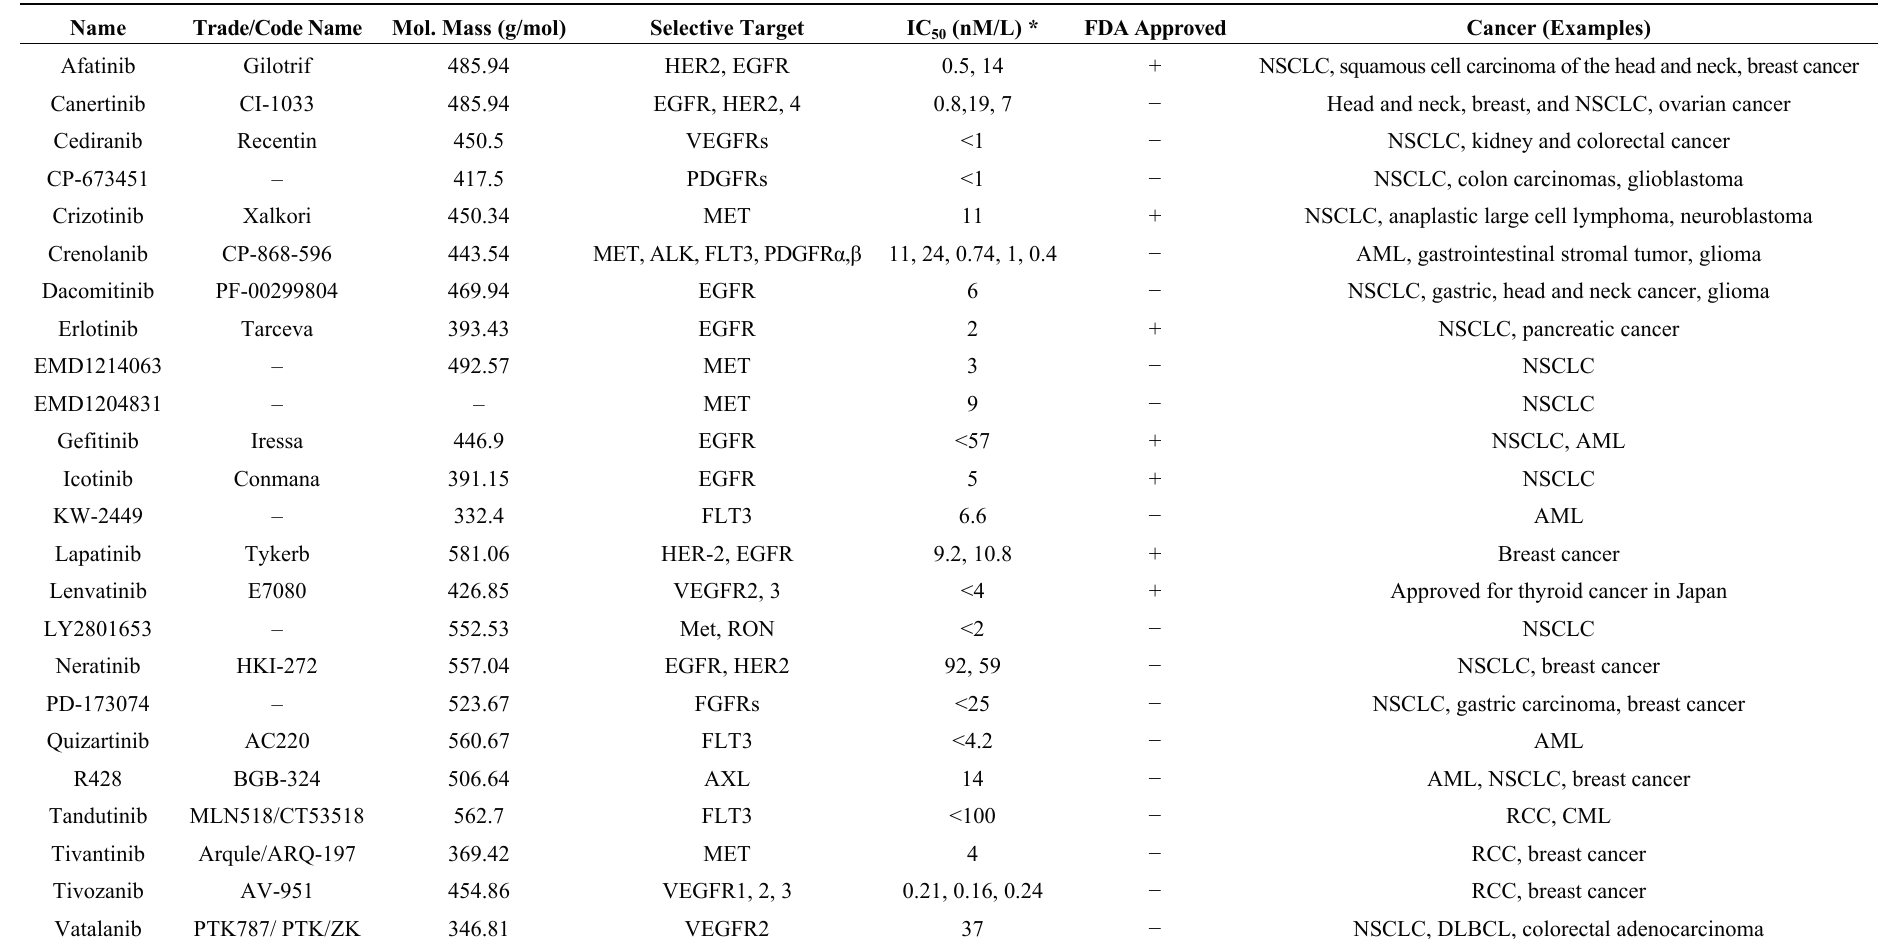
Table 2. Current specific/selective tyrosine kinase inhibitors (TKIs) targeting receptor tyrosine kinases